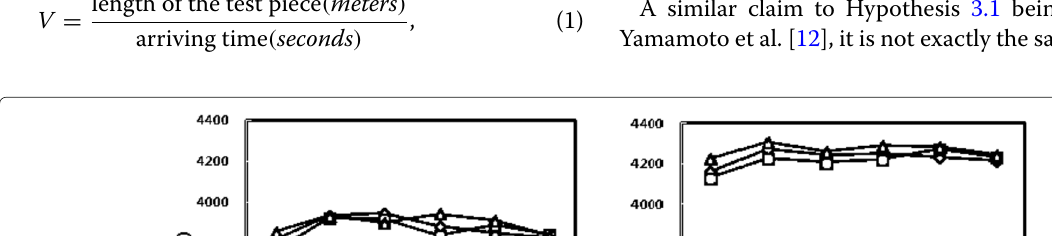
velocityis,whichisbecauseofthefactthatthelower thepointsare,thelargertheirdensityis,causedby thegravitysettlingofcementandfineaggregate. • Wecanconcludethatforthetestpiecesofthelength lessthan 1200 mm ,thereisnodecayoftheacoustic velocityfromtheviewpointofitsfirstarrivingtime. The last property is essentially important for our study.